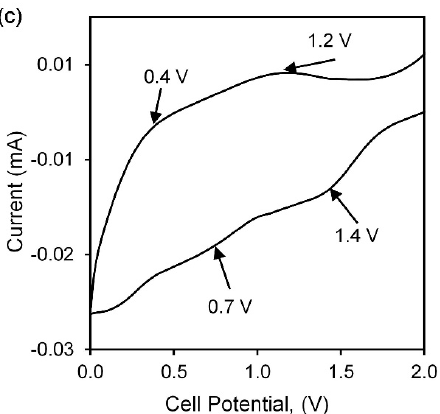
Figure 10. Graph of ( a ) linear sweep voltammetry, ( b ) cyclic voltammetry in range 0 to 3.5 V and ( c ) peaks observed in CV pattern of sample AMg30 polymer electrolyte.